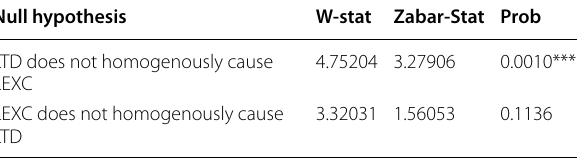
Table 11 Results of panel causality